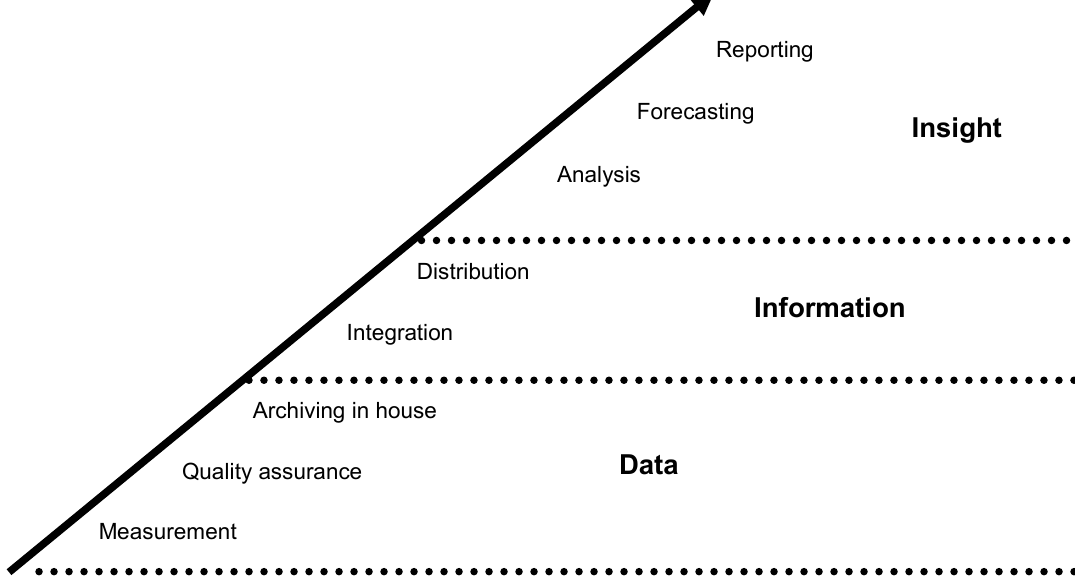
Reporting Forecasting Analysis